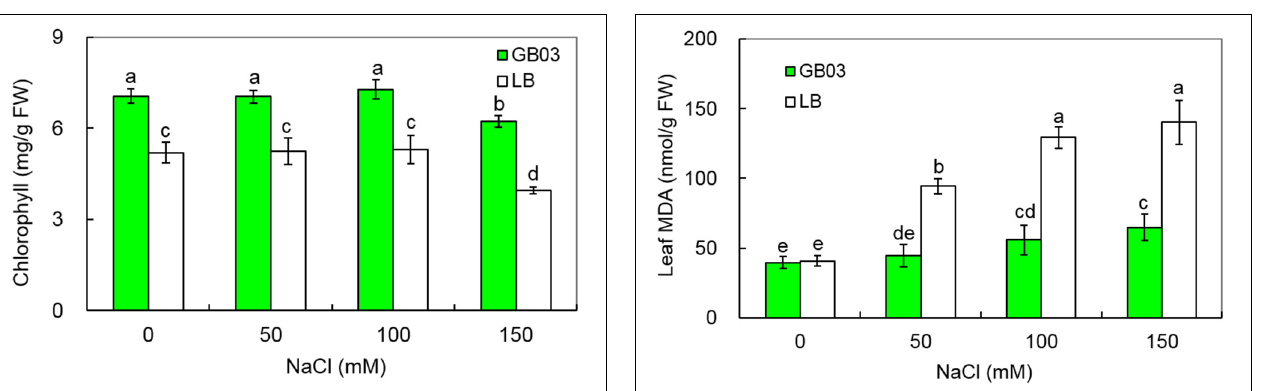
FIGURE 6 | Effects of GB03 bacterization on leaf malondialdehyde (MDA) content of white clover under various concentrations of NaCl. Values are means and bars indicate SDs ( n = 8). Columns with different letters indicate significant difference at P < 0 . 05 (Duncan test).